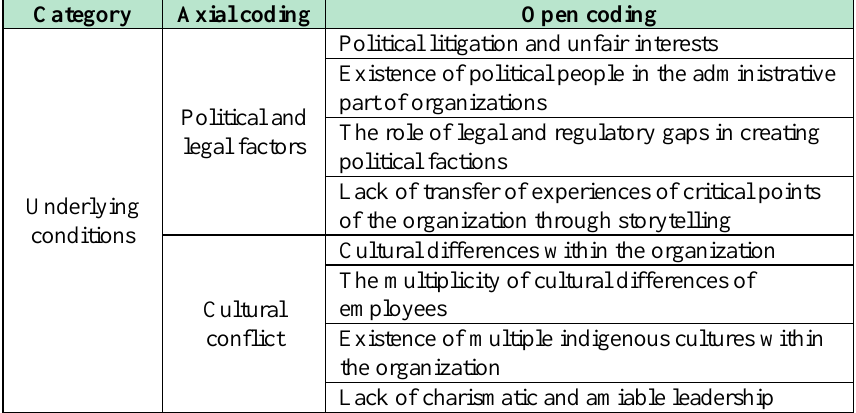
Table 4 - Open coding of qualitative data (background conditions) Category